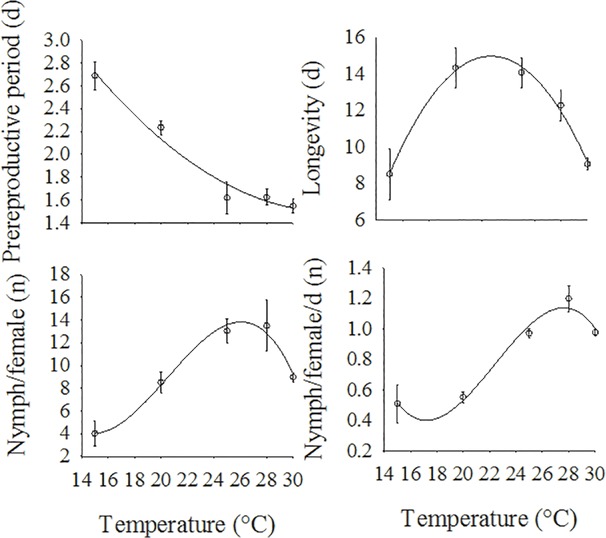
Effect of temperature on prereproductive period (y = 5.61–0.24x2 + 0.003x, F = 38.91, df = 2, 2, P = 0.0251, R2 = 0.9412), longevity (4.93x2 - 0.10x - 41.08, F = 97.69, df = 2, 2, P = 0.0101, R2 = 0.9816), nymph/female (-16.63x3 + 0.87x2 - 0.01x + 104.49, F = 157.33, df = 3, 1, P = 0.0467, R2 = 0.9409), and nymph/female/day (-1.86x3 + 0.08x2 - 0.001x + 13.10, F = 157.33, df = 3, 1, P = 0.0467, R2 = 0.9120) for apterous morphs of H. foeniculi. d = day.